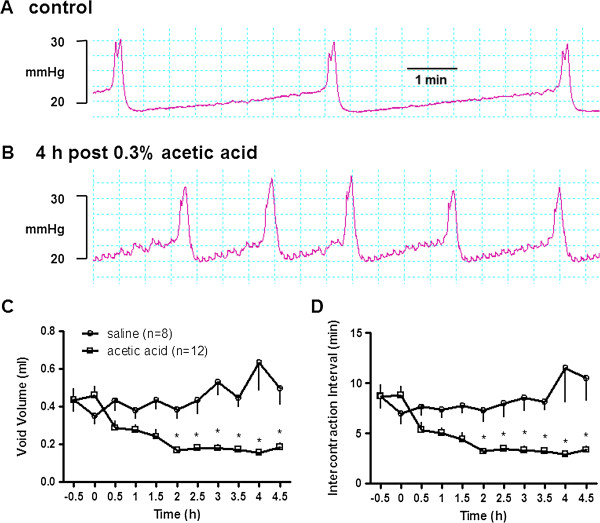
The urodynamic response to intravesical administration of 0.3% acetic acid. A and B. Bladder pressure recordings (mmHg) before and during intravesical injection of 0.3% acetic acid. C and D. Time course of the response on rat urodynamics to intravesical administration of 0.3% acetic acid. *P < 0.05, Repeated measures ANOVA, Bonferroni post test.